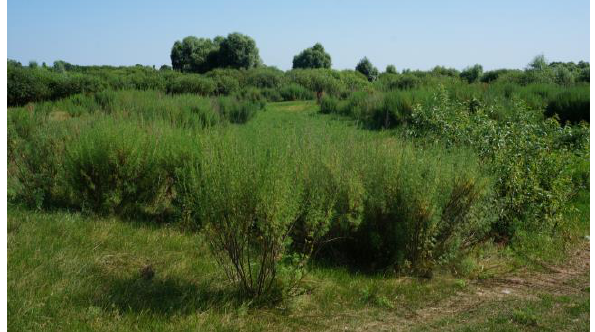
Fig. 4. Artemisia abrotanum L. in the floodplain of the River Sozh